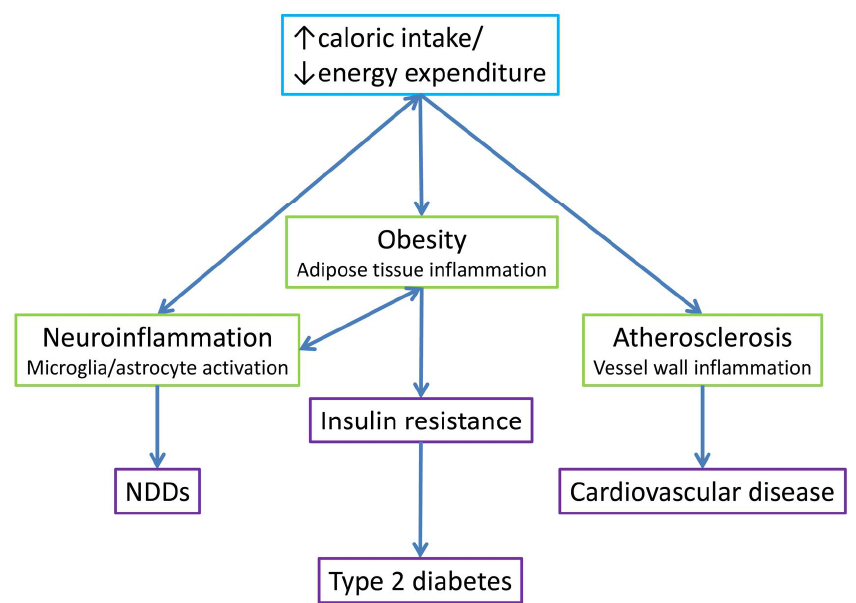
Figure 1. Interconnection between metabolism, inflammation, and neurodegeneration. An imbalance between caloric intake and energy expenditure has been linked to both metabolic disease (obesity and atherosclerosis) and neurodegenerative disorders. These pathologies all have a state of unresolved chronic inflammation in common. The link between neuroinflammation and obesity and associated sequelae is bidirectional, since hypothalamic inflammation leads to uncoupling of caloric intake and energy expenditure, leading to obesity, but also contributes to obesity-induced insulin resistance (and subsequent type 2 diabetes) via altered neurocircuit functions.